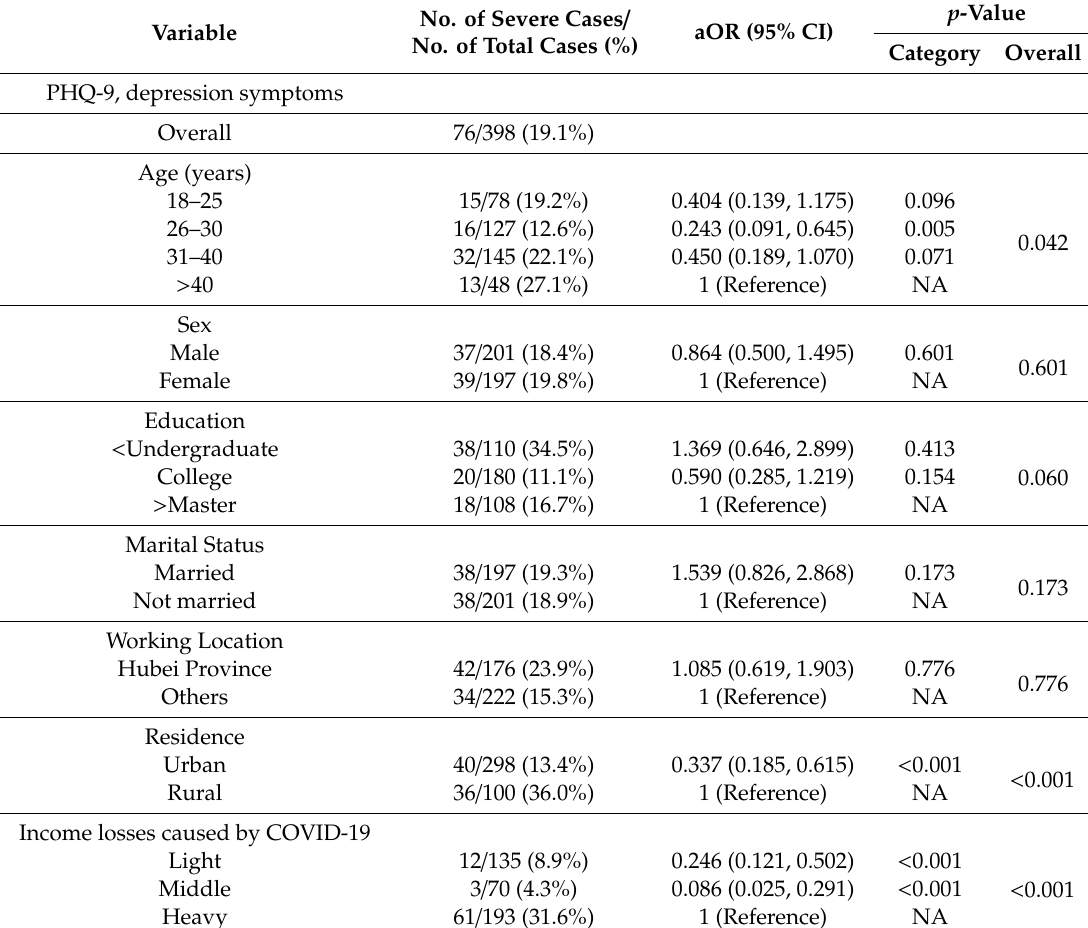
Table 4 lists the detailed results of PHQ-9 from multivariable logistic regression analysis; the results for the other scales are presented in Supplementary Materials (Tables S4–S6). Abbreviations: NA = Not Available; aOR: adjusted odds ratio; CI: confidence interval. PHQ-9: the Patient Health